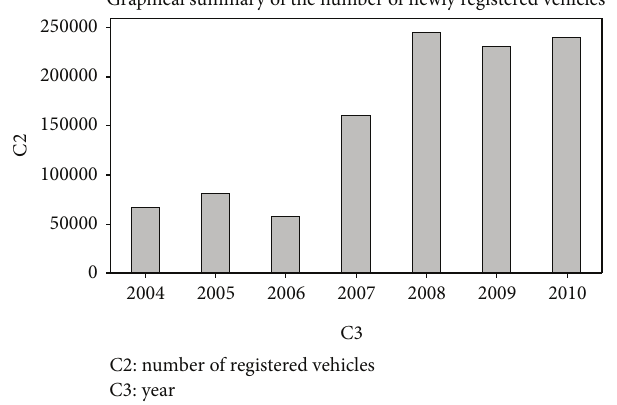
Figure 2: Bar chart of the number of newly registered vehicles.